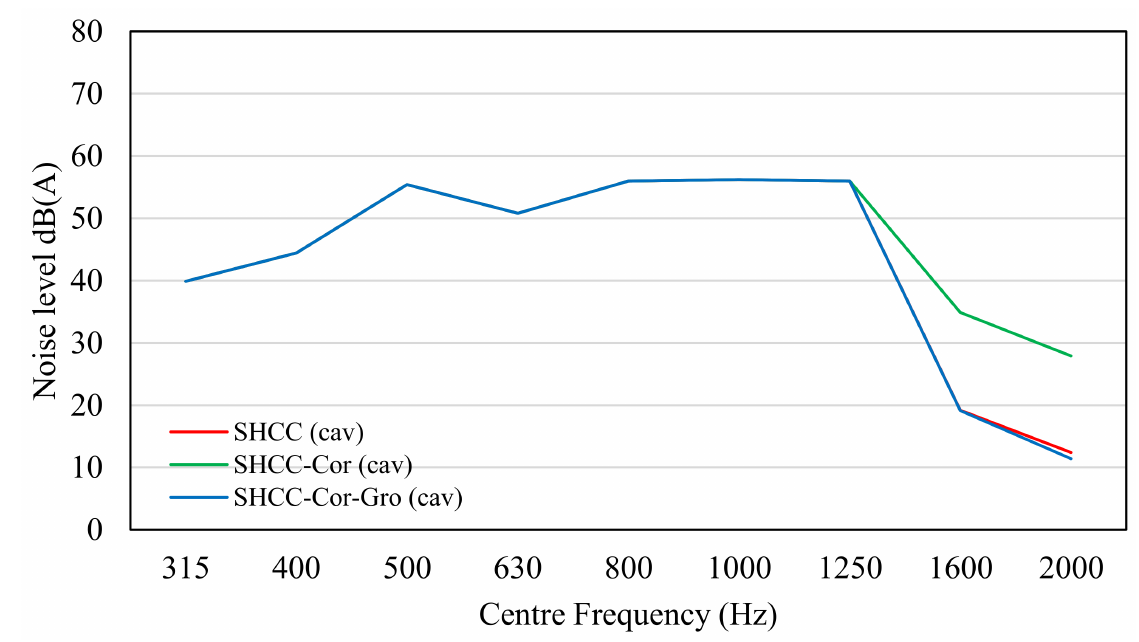
Figure 6. Noise level of SHCC, SHCC-Cor, and SHCC-Cor-Gro based on cavity parameter.